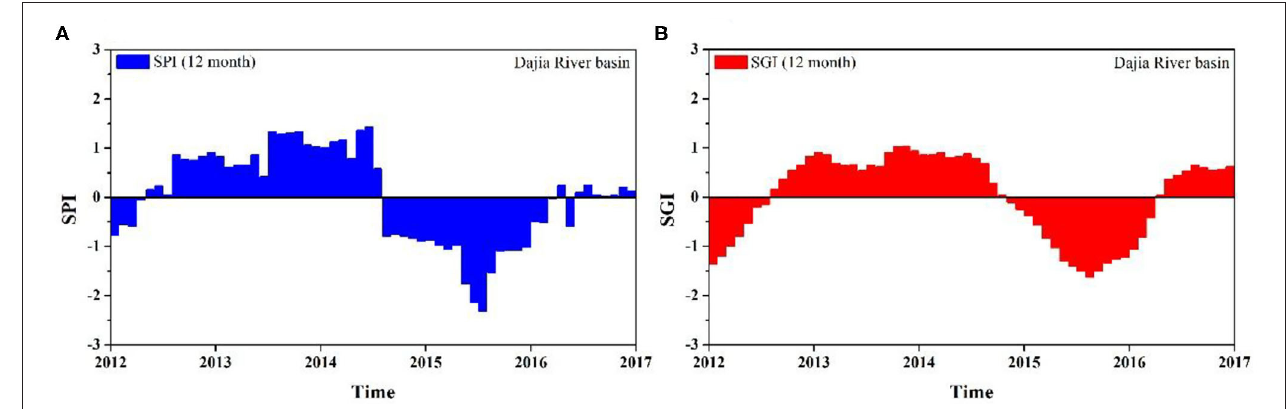
FIGURE 4 | (A,B) Long-term ( q = 12) SPI and SGI analysis results for the Dajia River Basin.